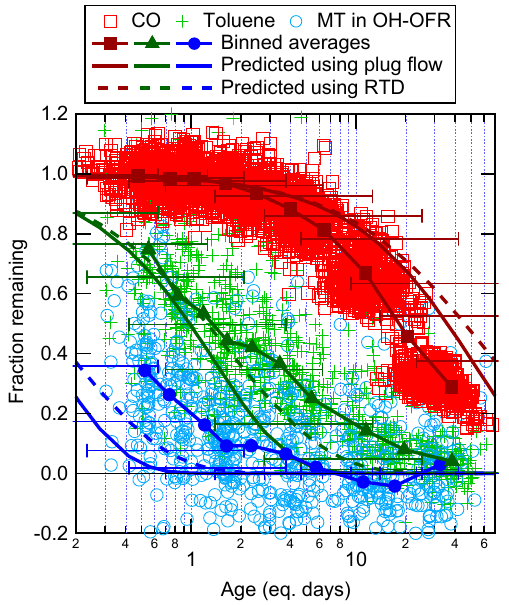
Figure 1. Fraction of ambient toluene, ambient MT, and injected CO remaining after OH oxidation in the OFR, as a function of equation-estimated photochemical age (Peng et al., 2015). Binned averages of the fraction remaining are also shown, compared to the amount predicted to remain assuming either plug flow or us- ing the residence time distribution (RTD) of particles from Lambe et al. (2011a). Factor-of-3 error bars are shown for the prediction us- ing RTD, representing the uncertainty in the model-derived OH exp estimation equation (Li et al., 2015; Peng et al., 2015).